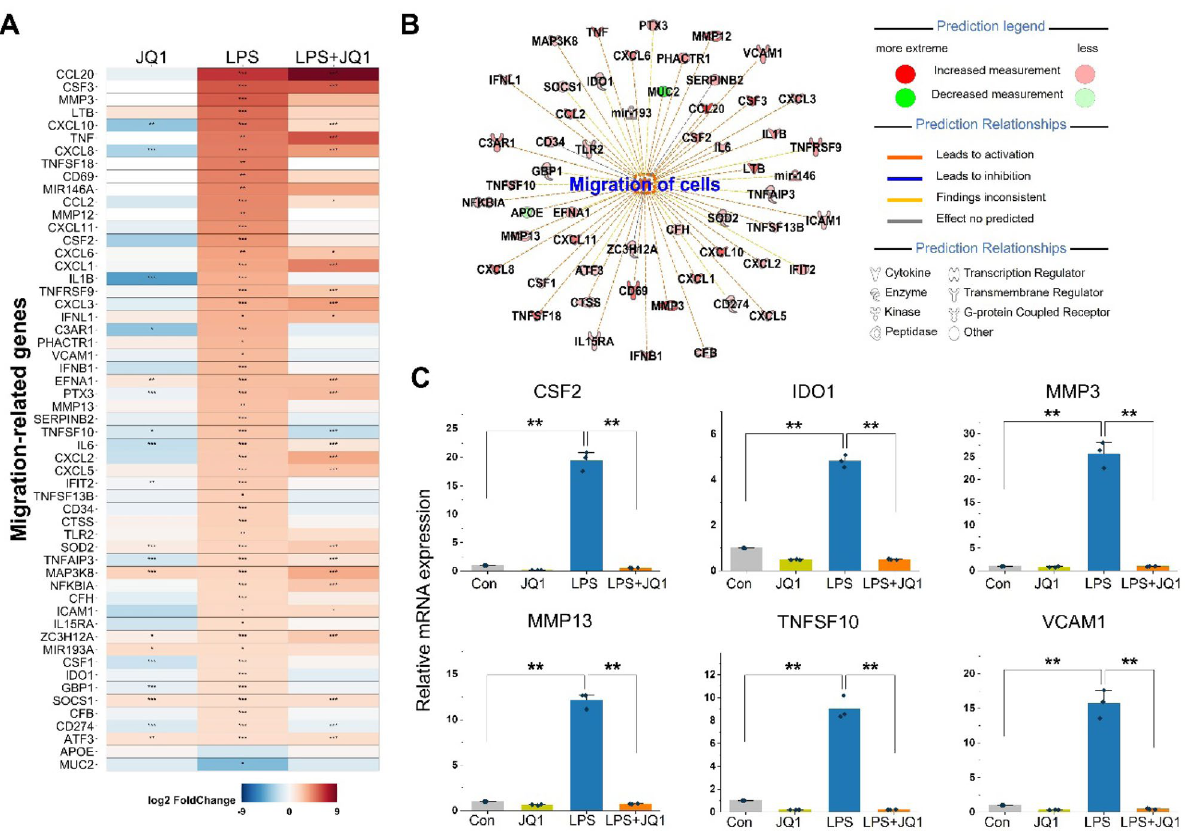
Figure 4. JQ1 inhibits a specific subset of LPS-inducible migratory genes. ( A ) Heat map showing migration- related gene expression in cells treated with LPS (100 ng/ml) and JQ1 (500 nM) at 4 h. The color scale shown in the heat map represents the log 2 fold change values. ( B ) IPA downstream effects analysis presenting the mapping of most significant genes related to migratory response genes in LPS-treated cells. ( C ) Expression levels of migration-related genes were analyzed by qRT-PCR and normalized to GAPDH transcript levels. Overall, LPS- induced migratory genes were inhibited by JQ1. The data represent three independent experiments. The values are the mean ± SEM of triplicate experiments (** p <